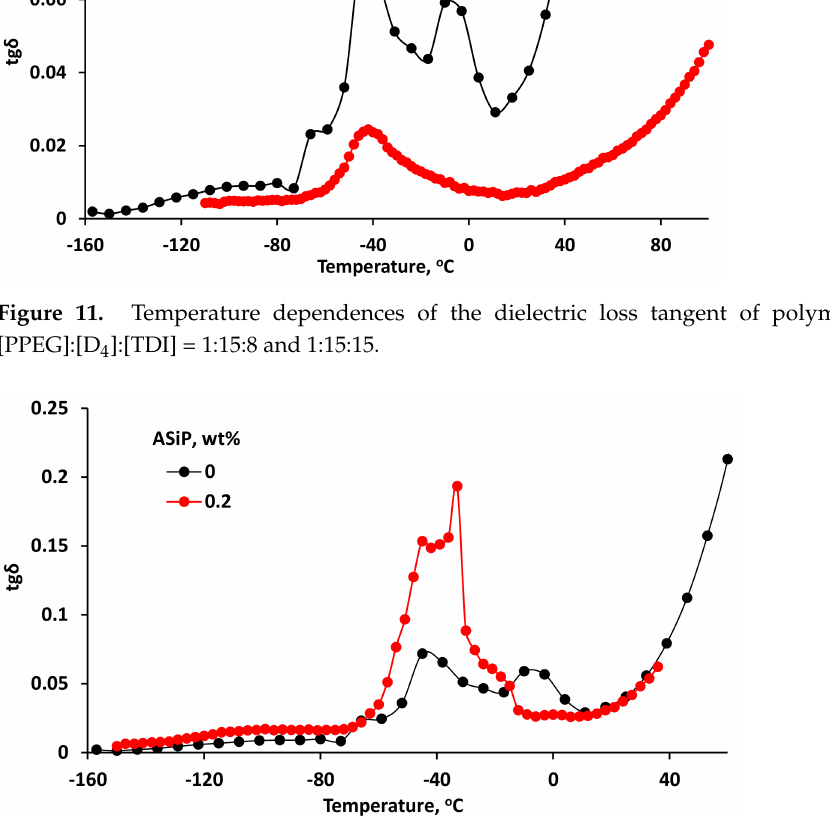
Figure 12. Temperature dependences of the dielectric loss tangent of polymers based on [PPEG]:[D 4 ]:[TDI] = 1:15:8 with [ASiP] = 0 and 0.2